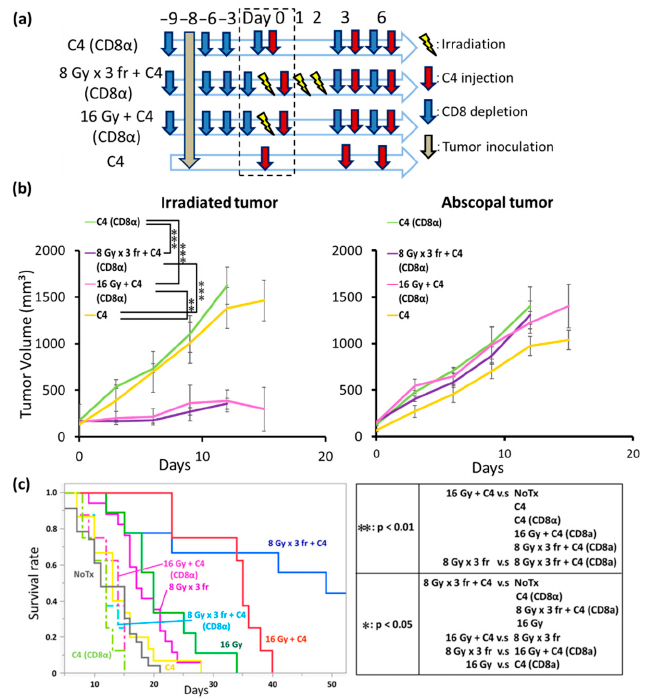
Figure 7. CD8 depletion experiments. ( a ) The experimental scheme. ( b ) The tumor volume changes of the irradiated and abscopal tumors. Tukey–Kramer’s HSD test was performed 15 days after the final treatment to compare the differences in tumor volume between C4 (CD8 α ) (N = 8), 8 Gy × 3 fr + C4 (CD8 α ) (N = 8), 16 Gy + C4 (CD8 α ) (N = 8), and C4 (N = 14) groups. The data of the C4 group are shared in Figure 5. ( c ) Overall survival. The Wilcoxon test with a post adjustment test by Bon- ferroni correction was performed to compare the difference among 9 groups. (NoTx, N = 23; C4, N = 14; 8 Gy × 3 fr, N = 11; 8 Gy × 3 fr + C4, N = 8; 16 Gy, N = 7; 16 Gy + C4, N = 7; C4 (CD8 α ), N = 8; 8 Gy × 3 fr + C4 (CD8 α ), N = 8; 16 Gy + C4 (CD8 α ), N = 8). The data of NoTx, C4, 8 Gy × 3 fr, 16 Gy, 8 Gy × 3 fr + C4, and 16 Gy + C4 groups are shared in Figures 4 and 5. Each error bar represents SE. ***: p < 0.001, **: p < 0.01, *: p < 0.05. Abbreviations—C4: anti-CTLA-4 antibody; CD8 α : anti-CD8 antibody; C4 (CD8 α ): anti-CTLA-4 antibody with the anti-CD8 antibody; 8 Gy × 3 fr + C4 (CD8 α ): 8 Gy × 3 fraction with anti-CTLA-4 and anti-CD8 antibodies; 16 Gy + C4 (CD8 α ): with anti-CTLA-4 and anti-CD8 antibodies; fr: fraction. 4. Discussion The standard treatment for PDAC includes surgery, chemotherapy, radiation ther- apy, and their combination. However, their treatment outcomes have poor overall sur- vival, especially at the advanced stage. ICIs have attracted attention for a variety of ad- vanced tumors [5–7]; however, the response rate for patients with PDAC has remained low due to the unique tumor microenvironments, including thick stroma, and the abun- dance of immune suppressive cells [8,9]. However, the effect of C4 in combination with local radiation on anti-tumor efficacy at irradiated and abscopal tumors was unclear for PDAC. To our best knowledge, this is the first report that demonstrated the combination therapy of high dose local irradiation with C4, which revealed the local and systemic anti- tumor effect and alters the tumor immune microenvironments not only in irradiated but also in the abscopal tumors in a PDAC mouse model.